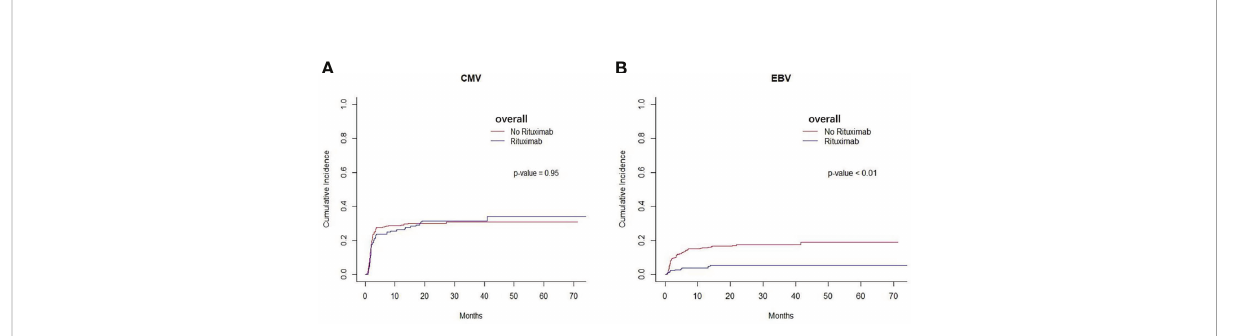
FIGURE 3 Infection of the entire cohort between two groups. (A) The cumulative incidence of CMV in entire patient cohort. There was no difference in the cumulative incidence of CMV between rituximab and non- rituximab groups in entire patient cohort (P= 0.95). (B) The cumulative incidence of EBV in entire patient cohort. There was comparable in the cumulative incidence of EBV between 2 groups in entire patient cohort (P < 0.01).